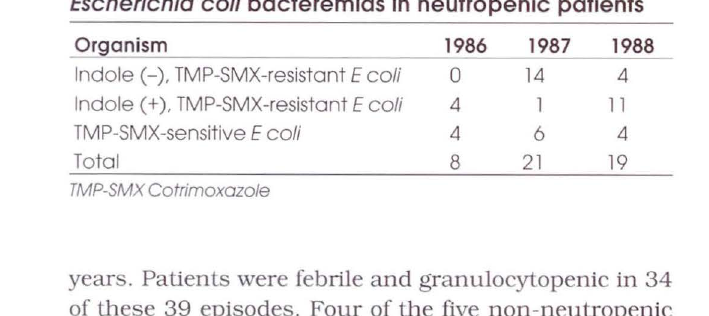
Escherichia coli bacteremias in neutropenic